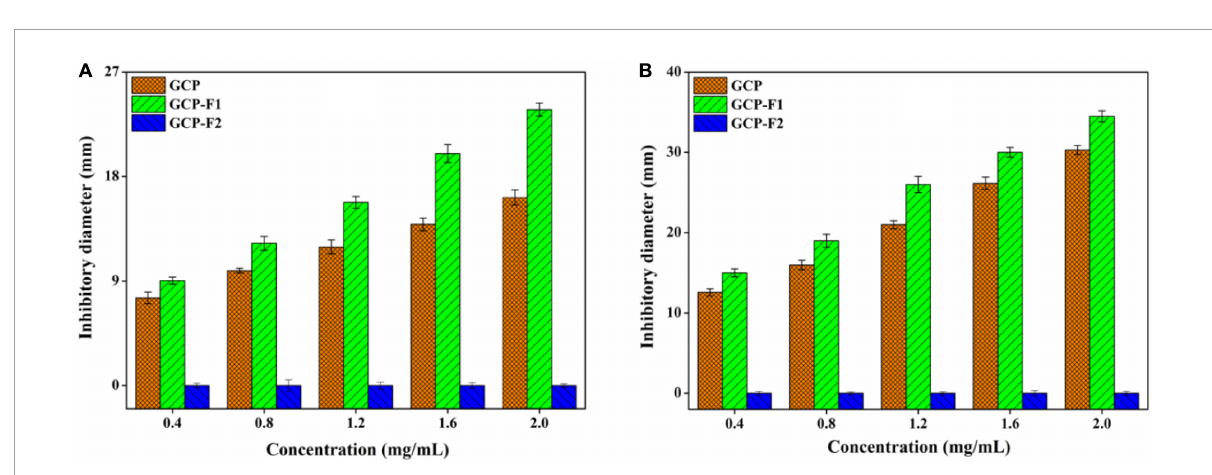
FIGURE5 Antibacterial activities of Genistein Combined Polysaccharide (GCP), GCP-F1, and GCP-F2 against E. coli (A) and S. aureus (B) .